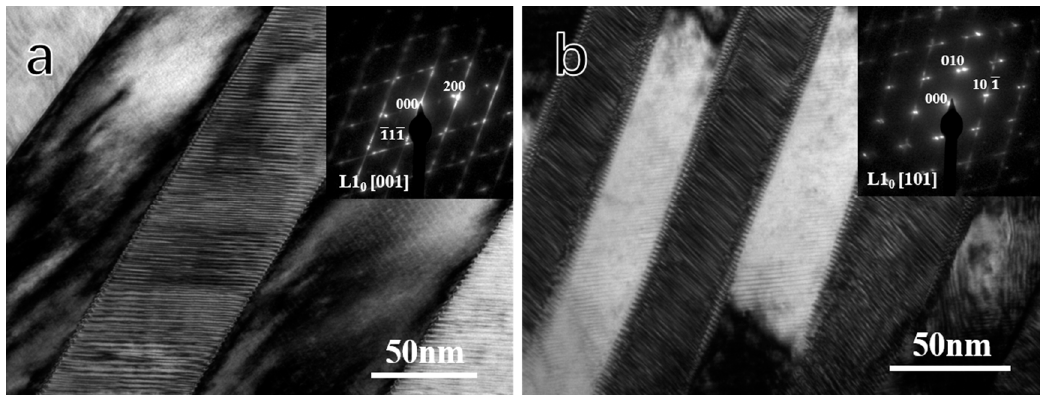
Figure 8. Transmission electron microscopy (TEM) micrograph and corresponding selected area electron diffraction patterns (SADP) of martensite: ( a ) D4; ( b ) D1.